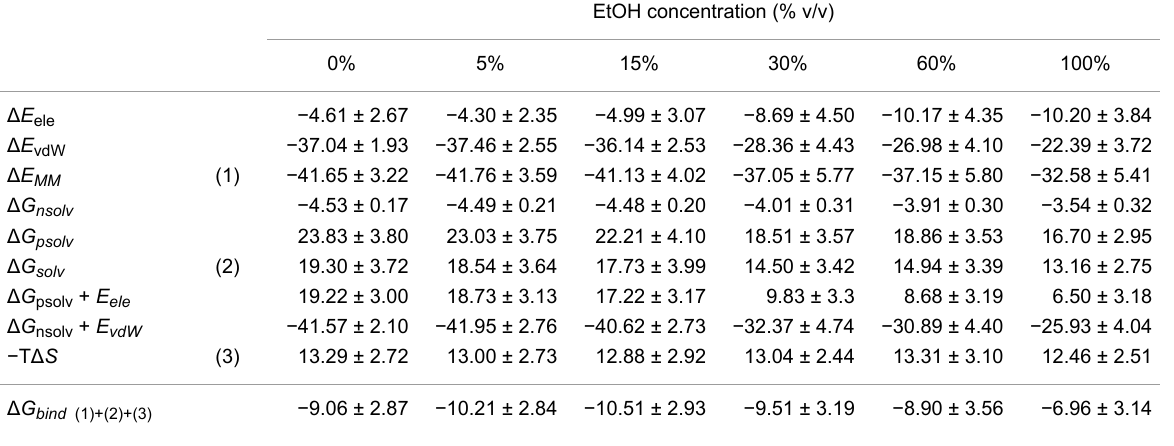
Table 5: MM-PBSA binding free energies (kcal/mol) and their energy components for α -MGS/ β -CD complexes at different EtOH